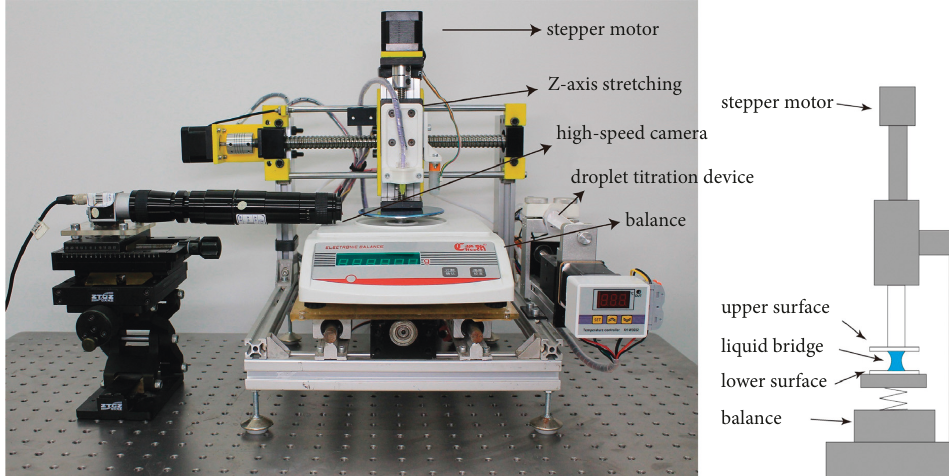
Figure 15: Liquid bridge tensile test